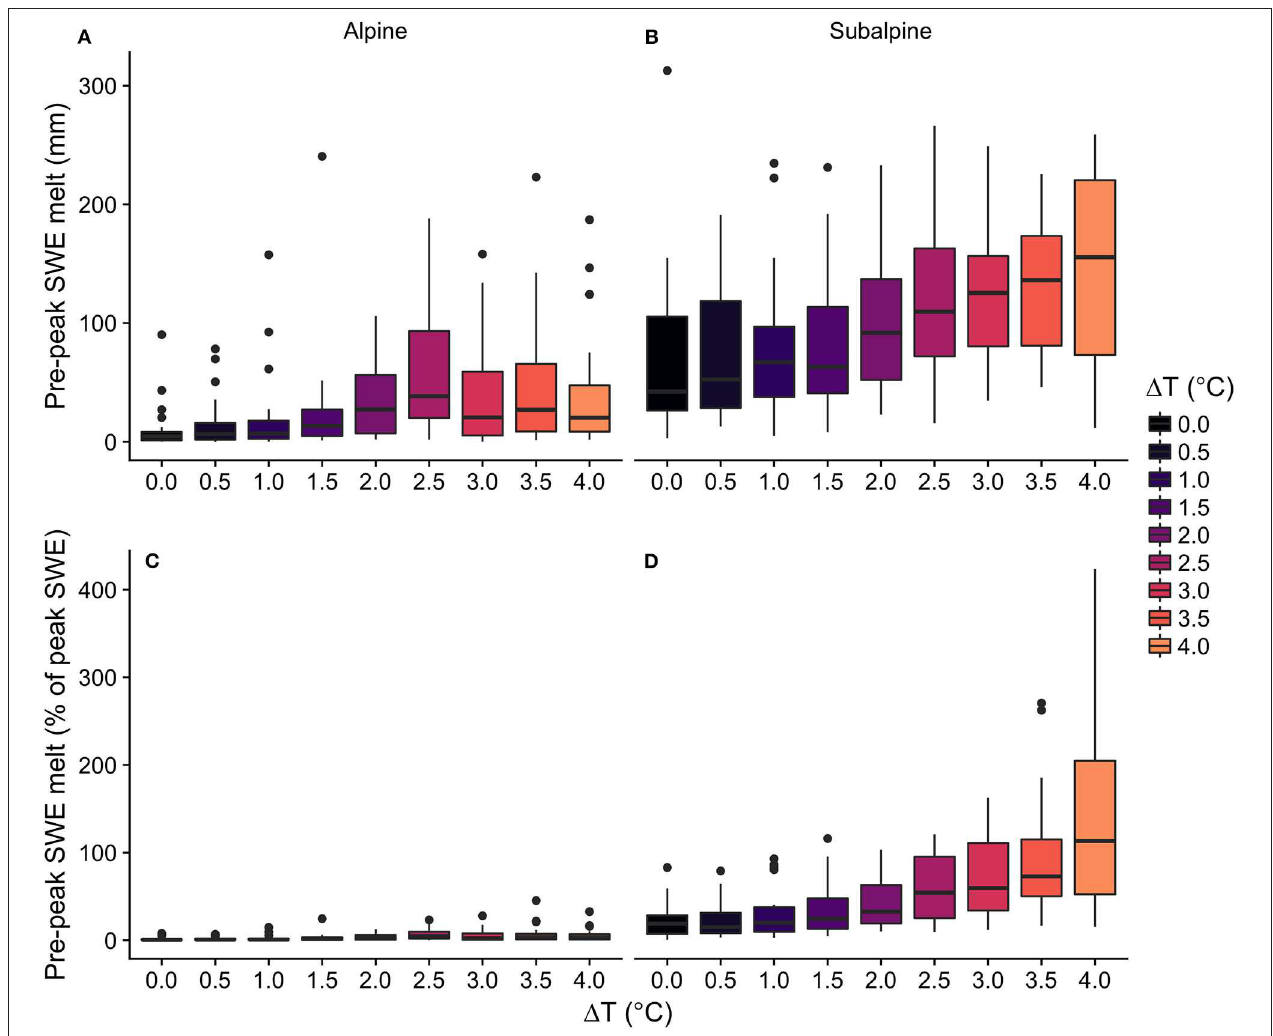
FIGURE 8 | Total snowmelt before peak SWE presented as a depth (A,B) and as a percentage of peak SWE (C,D) in the alpine (left column) and subalpine (right column).